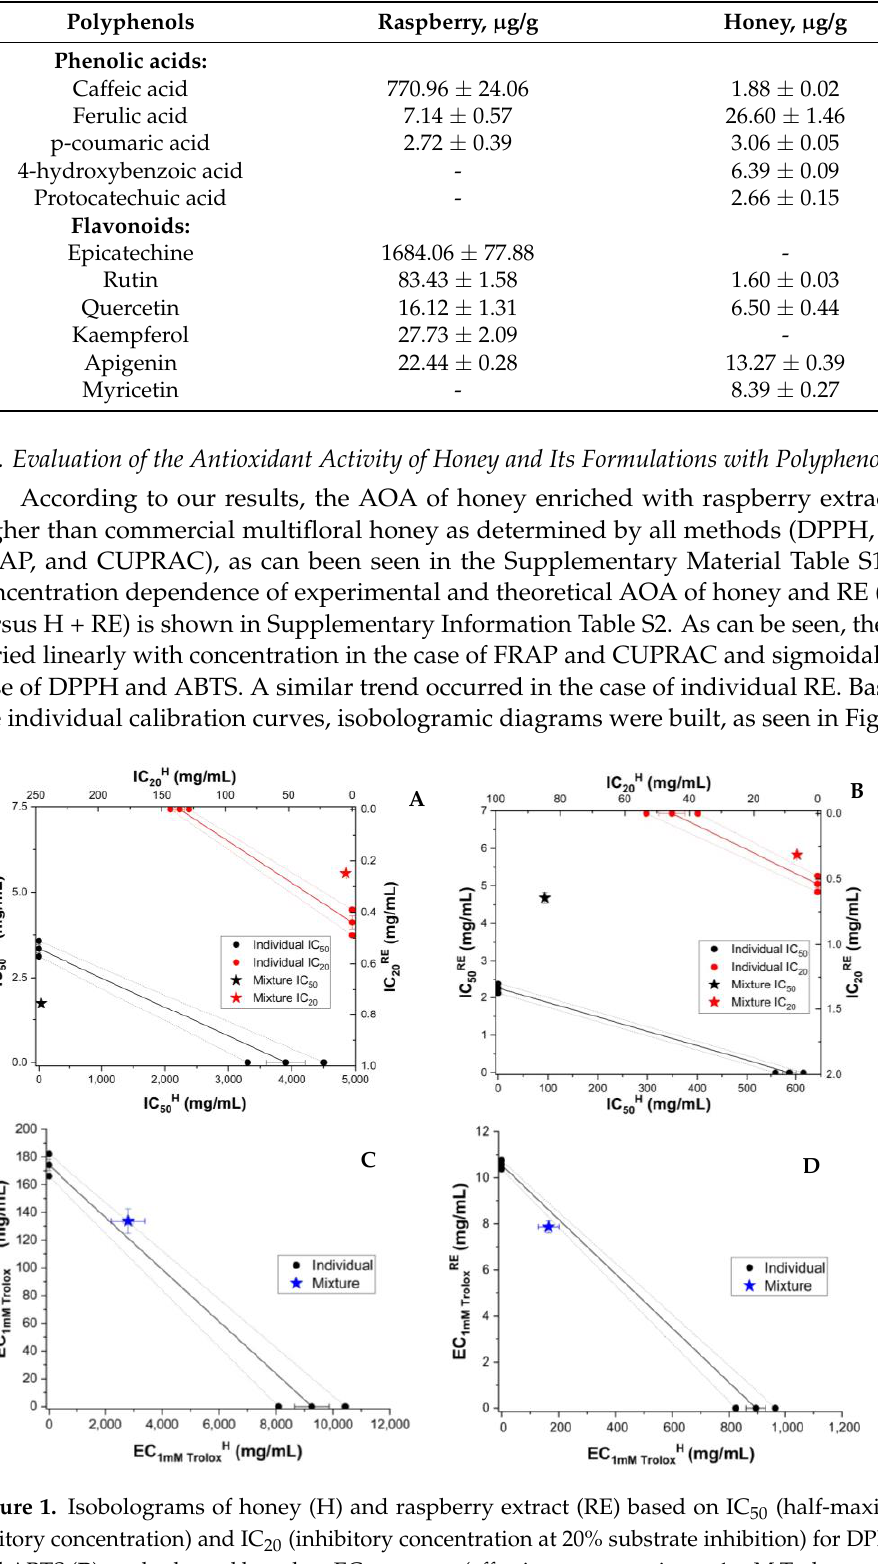
Table 3. Combination index (CI) between samples in AOA assays. AOA Method